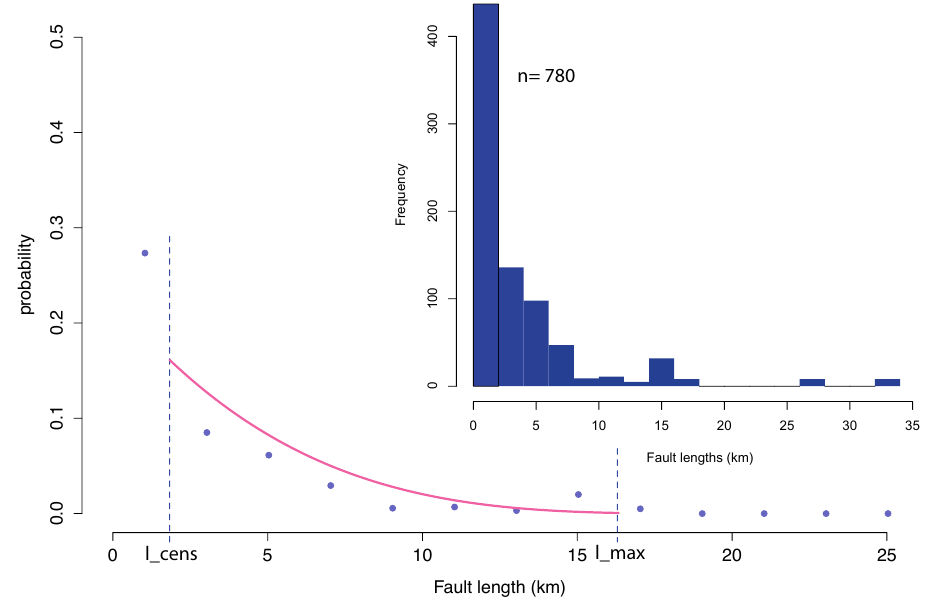
Fig. 2. Statistics for the fault lengths and estimation of the Weibull modulus for the Magadi Faults. The histogram is inserted to highlight the measured number of faults.